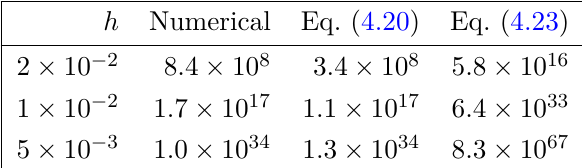
Table 2 . The ratio f ? ( t − ) /f ? ( t + ) , based on the numerical calculation (Numerical) and eq. (4.20), taking q = 10 − 2 . We take several values of q and H (parameterized as H = hq 2 m we also show the value of the right-hand side of eq.